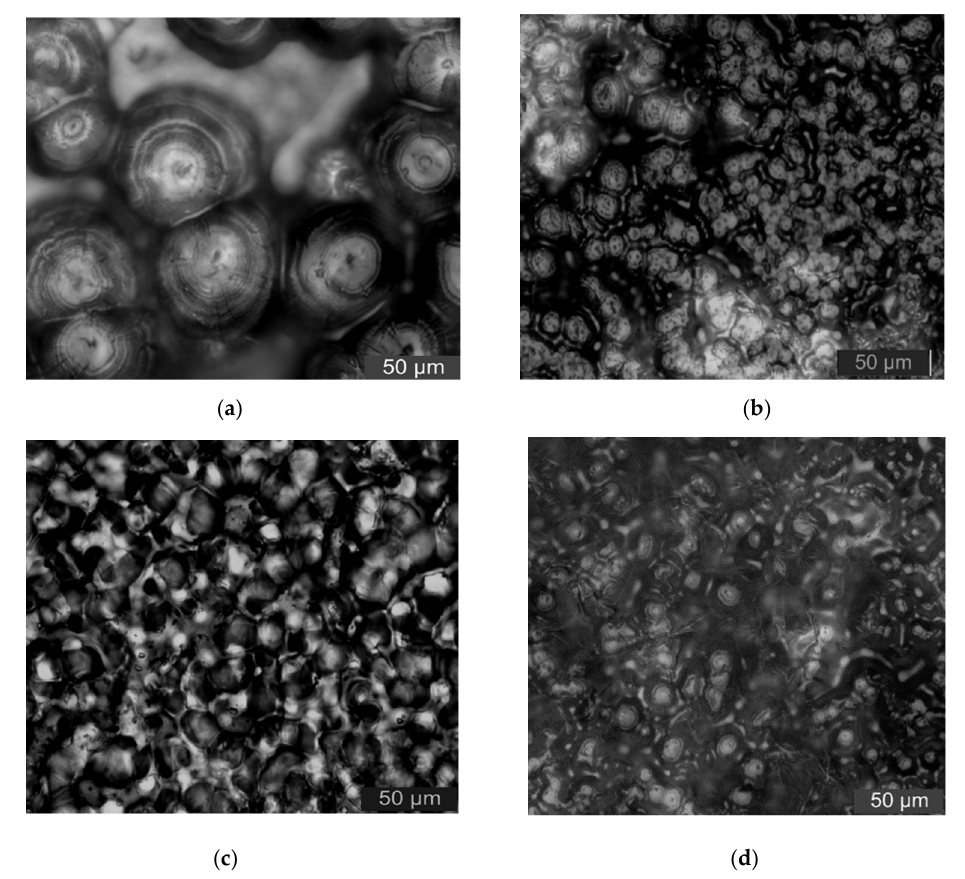
Figure 2. PLM patterns of different samples ( a ) LDPE; ( b ) N5; ( c ) M5; ( d ) N3M2.